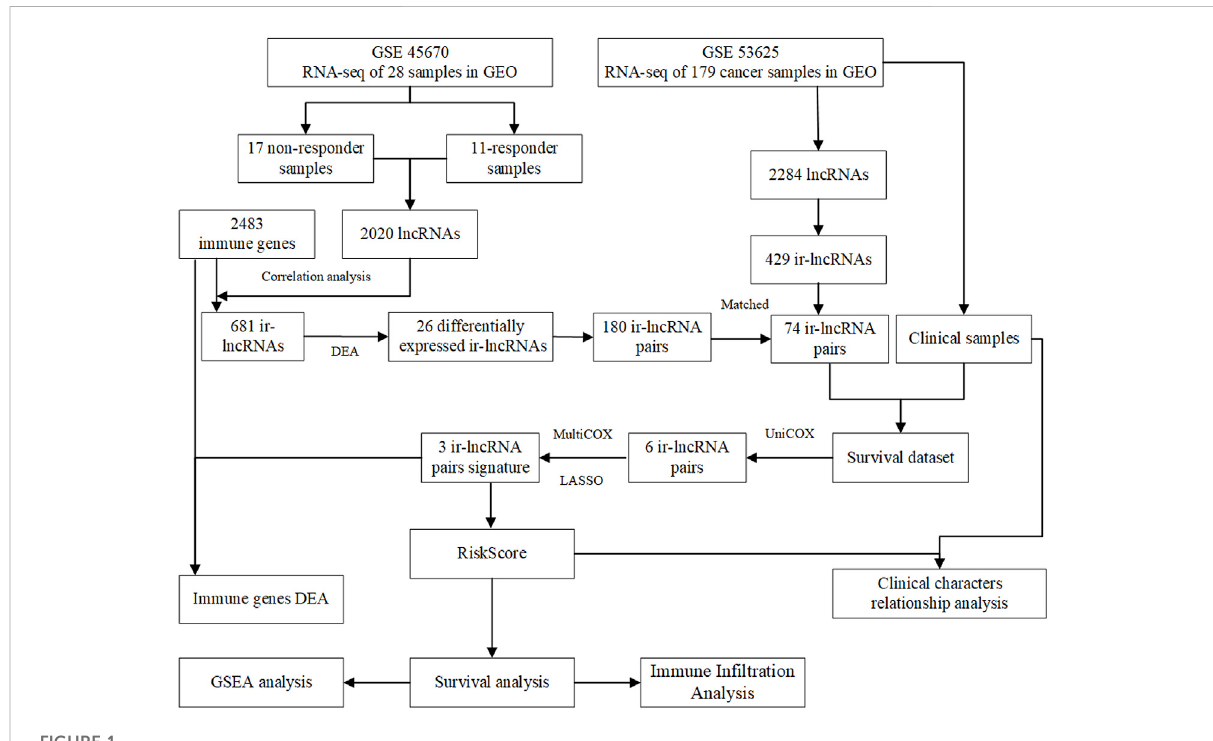
FIGURE 1 Flow chart of data collection and